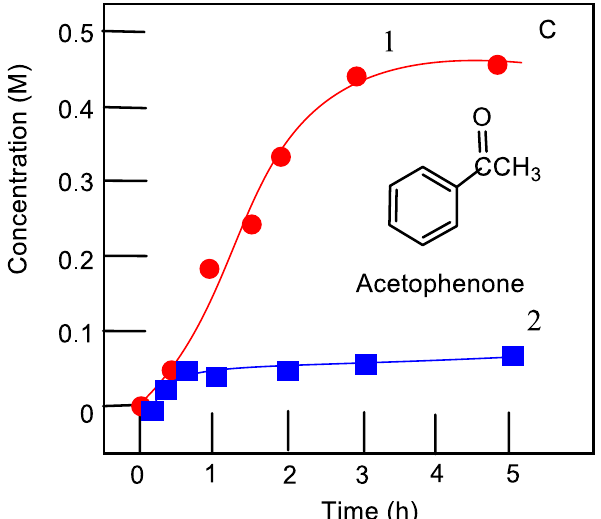
Figure 12. Accumulation of 2-heptanone (graph A ), cyclohexanone (graph B ), and acetophenone (graph C ), (curve 1), in the oxidation of 2-heptanol (0.42 M), cyclohexanol (0.5 M), and 1-phenylethanol (0.5 M), respectively, with tert -butyl hydroperoxide (1.5 M) catalyzed by complex 2 (5 × 10 − 4 M) at 50 ◦ C in acetonitrile. Accumulation of acetophenone (graph C , curve 2) in the oxidation of 1- phenylethanol (0.5 M) with H 2 O 2 (2,0 M) catalyzed by complex 2 (5 × 10 − 4 M) at 50 ◦ C in acetonitrile. To quench the oxidation process, concentrations of products were measured by GC only after reducing the reaction sample with solid PPh 3 .